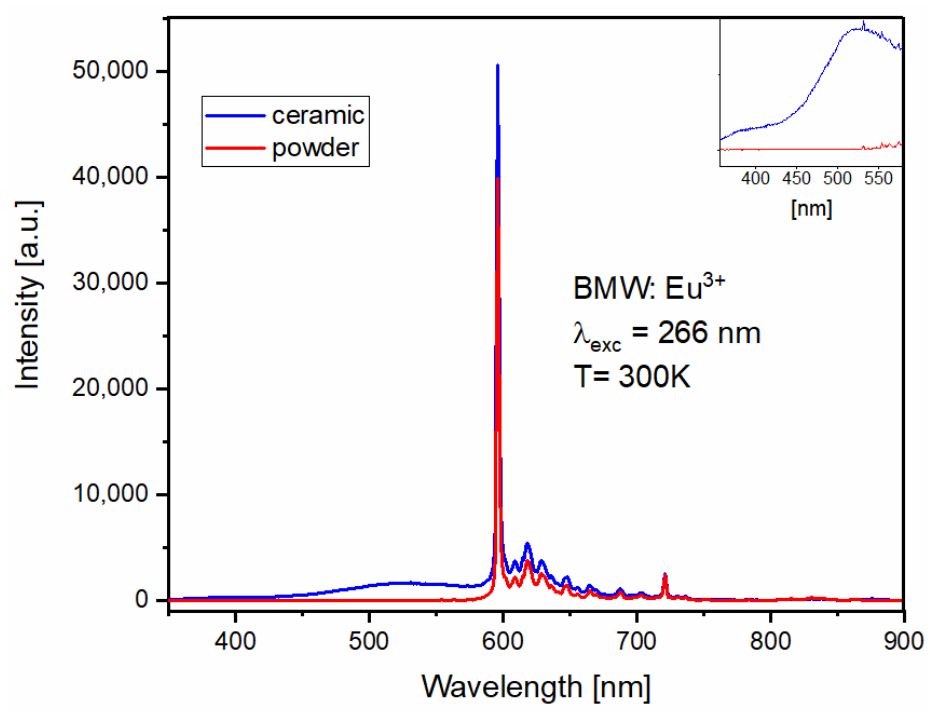
Figure 9. 300-K emission spectra of BMW-Eu powder and ceramic under 266-nm excitation. To evaluate the impact of the form of material on the efficiency of the energy transfer process from the WO 6 groups to Eu 3+ ions, the energy transfer efficiency ( η ET ) was Bode and Oosterhout [25] assigned blue-green and yellow-green emission bands to calculated using the following Equation